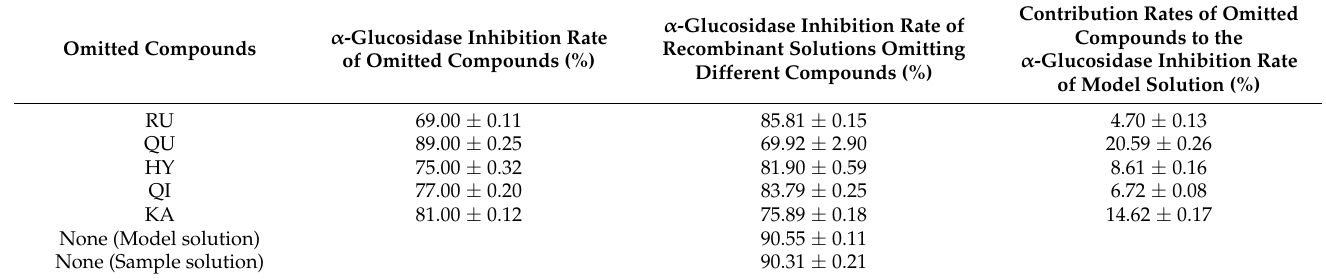
Table 2. α -Glucosidase inhibition rates of omitted compounds and recombinant solutions, and contribution rates of omitted compounds to the α -glucosidase inhibition rate of the model solution. Contribution Rates of Omitted Compounds to the Omitted Compounds α -Glucosidase Inhibition Rate Different Compounds (%) of Model Solution (%)